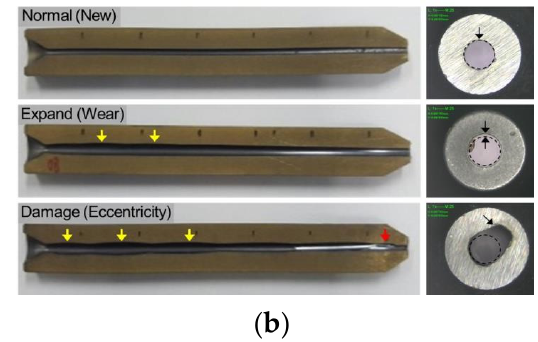
Figure 4. Photographs of normal, expanded, and damaged nozzles at a waterjet pressure of 350 MPa and an abrasive feed rate of 450 g/min: ( a ) nozzle diameters and ( b ) cross-sectional shapes.